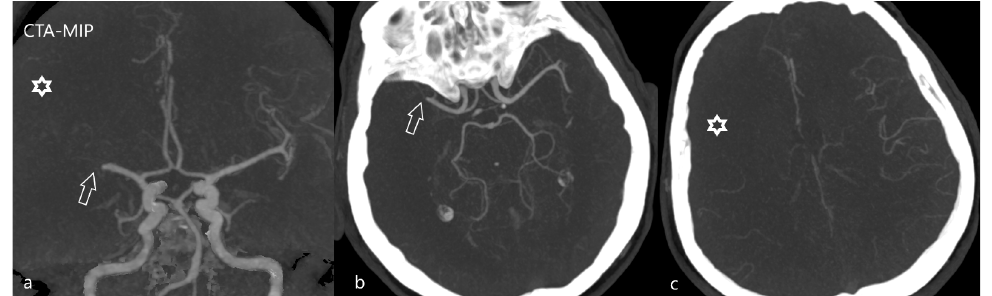
Figure 6. Malignant type of collaterals. CT angiography with maximum intensity projection recon- struction (CTA-MIP) depicts malignant collaterals in a patient with the occlusion of the right MCA [( a , b )—arrow]. Leptomeningeal collateral vessels are insufficient, peripheral arterial branches are not visible [( a , c )—star; compare with normal filling of vessels on the healthy left side].